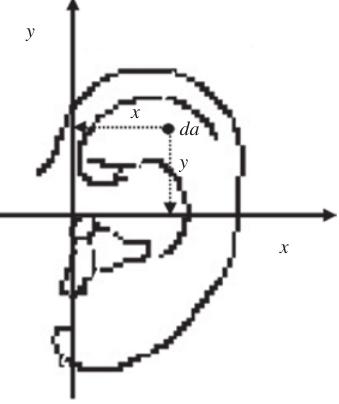
Figure 1: Geometrical Representation of the MI of a Differential about Two